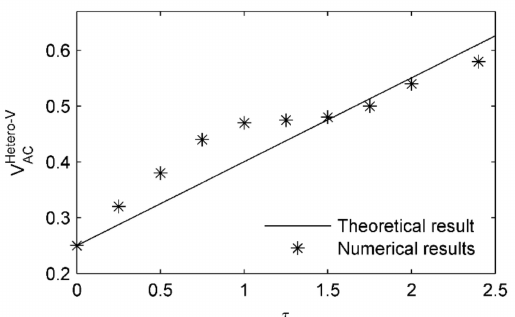
Figure 14. Variation of AC voltage threshold for heteroclinic bifurcation with τ when g v = 0.2.